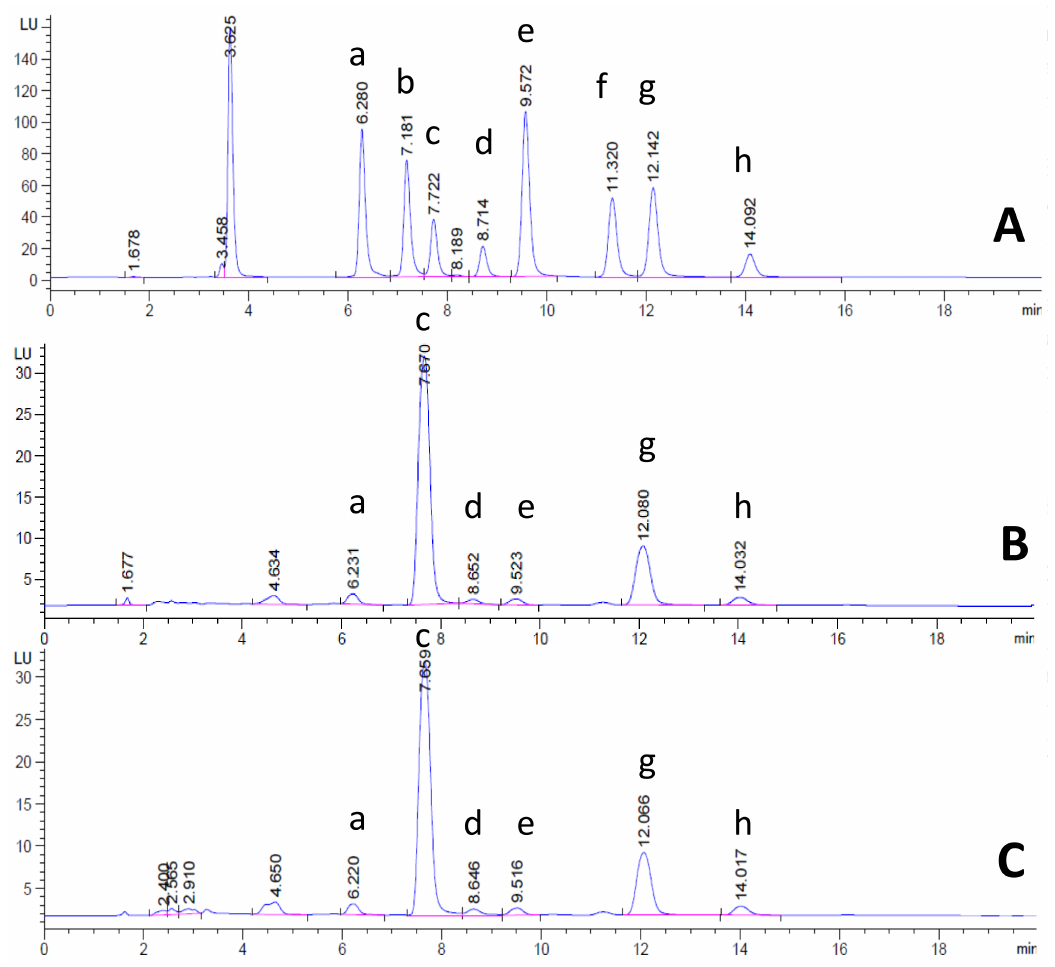
Figure 1. HPLC chromatogram of reference tocotrienols, tocopherols, and natural purple rice bran oils (NPRBOs). ( A ) Mixed reference tocotrienols and tocopherols, including δ -tocotrienol (a), β -tocotrienol (b), γ -tocotrienol (c), α -tocotrienol (d), δ -tocopherol (e), β -tocopherol (f), γ -tocopherol (g), and α -tocopherol; and NPRBOs including ( B ) Khao’ Gam Leum-Phua and ( C ) Khao’ Gam Pah